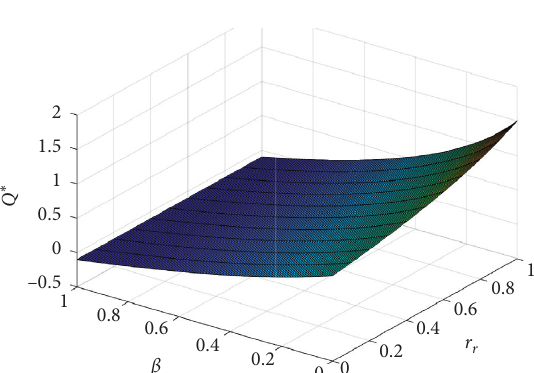
Figure 5: Effect of risk level β and unit residual value r optimal inventory quantity Q ∗ under RMI mode with stochastic demand in the water supply chain.